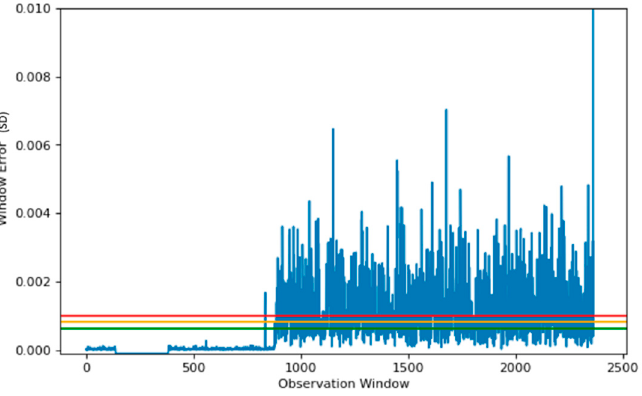
Figure 9. Reconstruction plot using SAE model, using a data window of 250, on known fault data. The lines denote the threshold based upon the healthy data used to train the model, starting at the 99.95% percentile, for the green threshold.